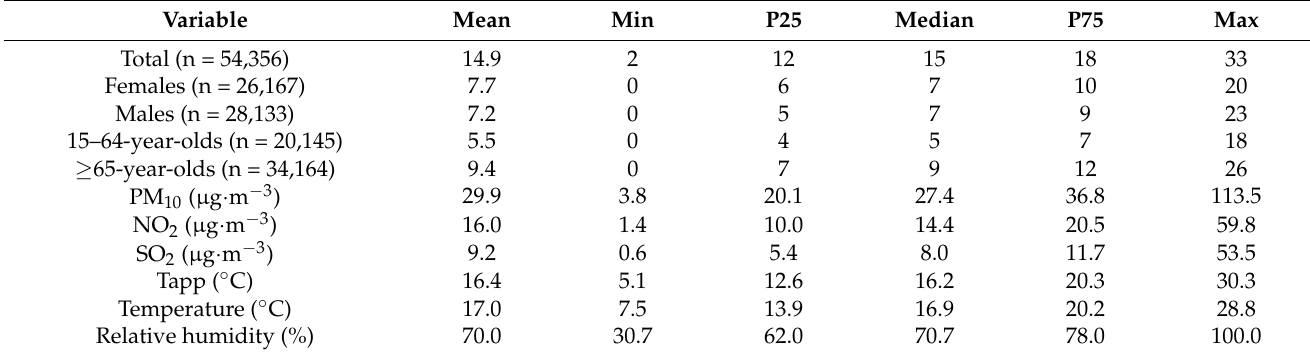
Table 1. Daily descriptive statistics of the cardiovascular disease deaths, air pollutants and meteoro- logical conditions in Cape Town, South Africa, 1 January 2006–31 December 2015 (3652